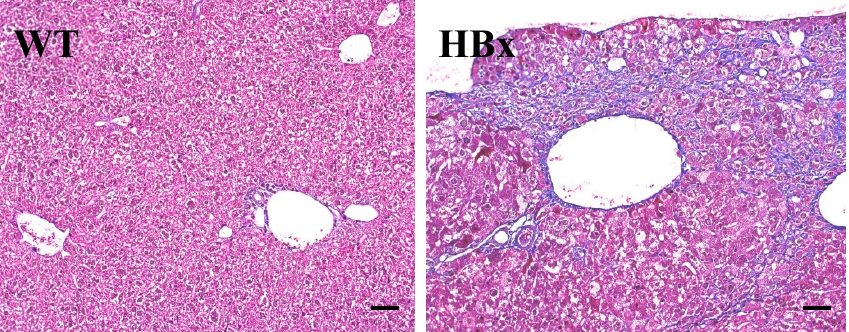
Figure 3. Masson’s trichrome staining for the liver histopathological examination of the livers from WT and HBx mice. (HBx) Di ff use fibrosis of hepatic subcapsule and fibrosis expansion without septa